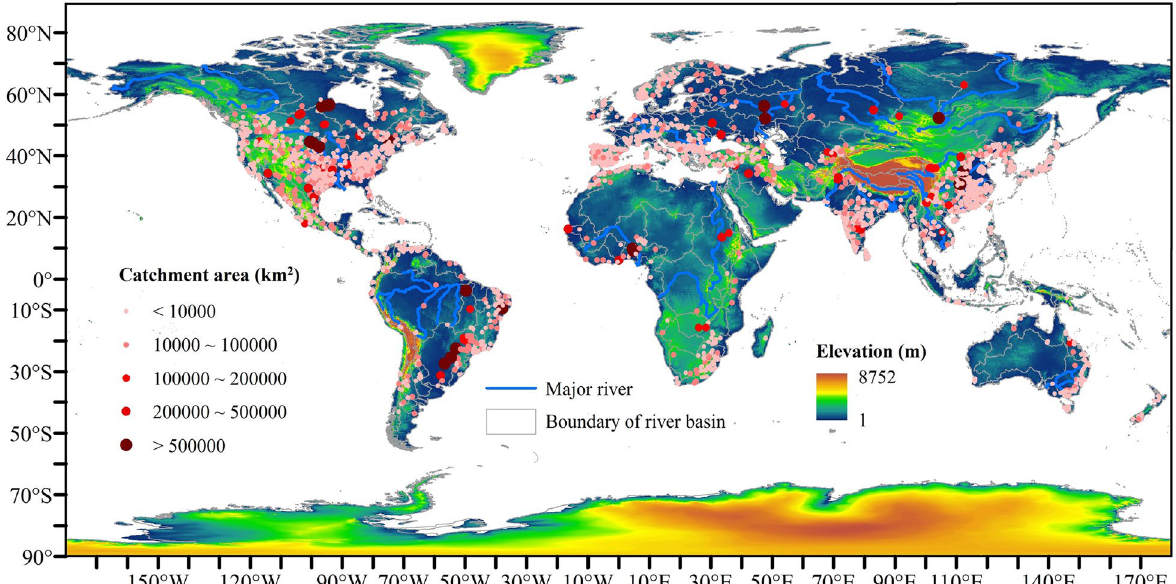
Fig. 1 Global map of the 2815 existing large dams constructed from 1900 to 2010, classified by their catchment area